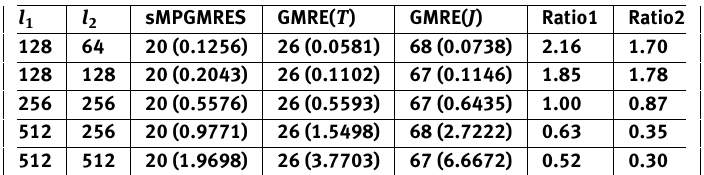
Table 3. The number of iterations and computing time in seconds (in brackets) for Example 4.1 when J and T are used as preconditioners. Ratio1 and Ratio2 are defined as (computing time of sMPGMRES)/(computing time of GMRES( T )) and (computing time of sMPGMRES)/(computing time of GMRES( J )), respectively.